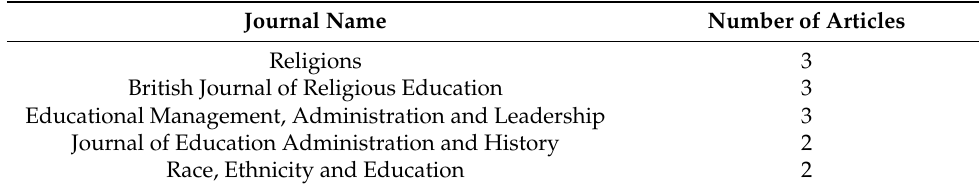
Table 1. The most popular journals for related studies.